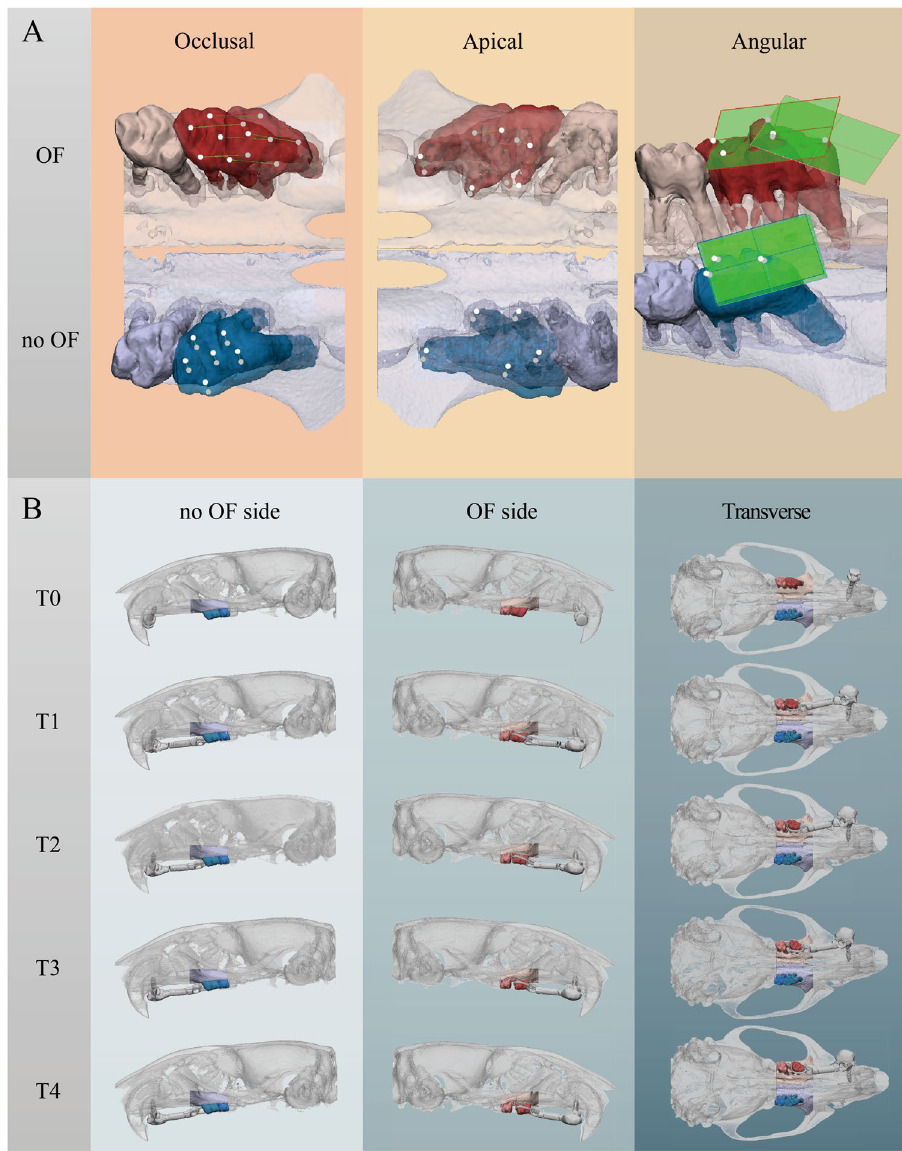
Figure 2. Longitudinal assessment of OTM. ( A ) In the T0 model, occlusal, apical points and occlusal plane were defined. Then, the same points were extrapolated into the T1–T4 models by automated global registration. The distances or angles between them were then measured as occlusal, apical or angular movement. ( B ) Dynamic changes in molar displacement and alveolar bone morphometry. (Red = OF side, Blue = No OF